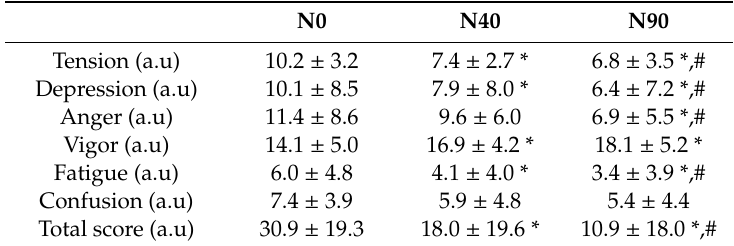
Table 3. Representation of the results of the profile of mood states recorded after the no-nap condition (N0) and the 40-min (N40) and the 90-min (N90) nap opportunities. N0 N40 N90